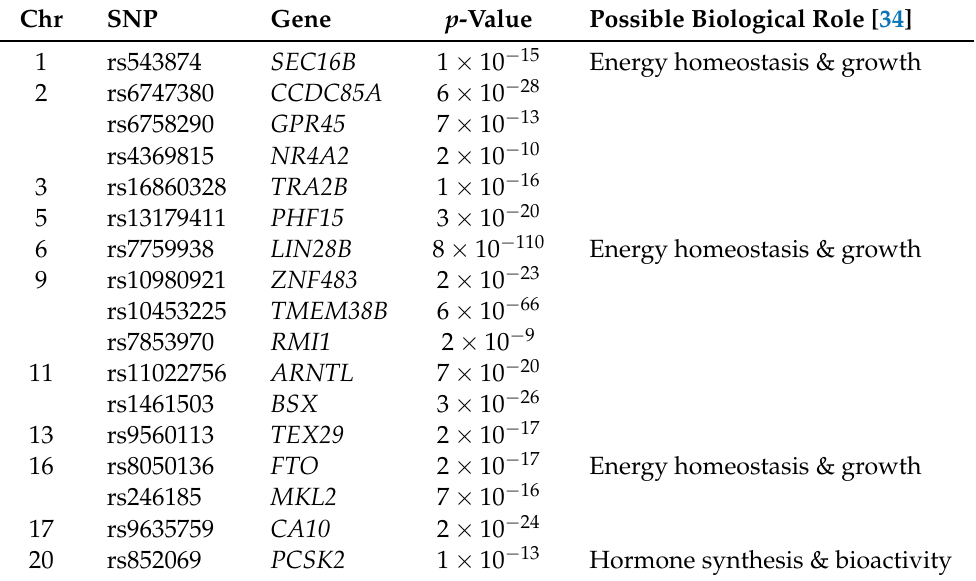
Table 1. Summary of the 17 instrument SNPs selected for MR analysis.